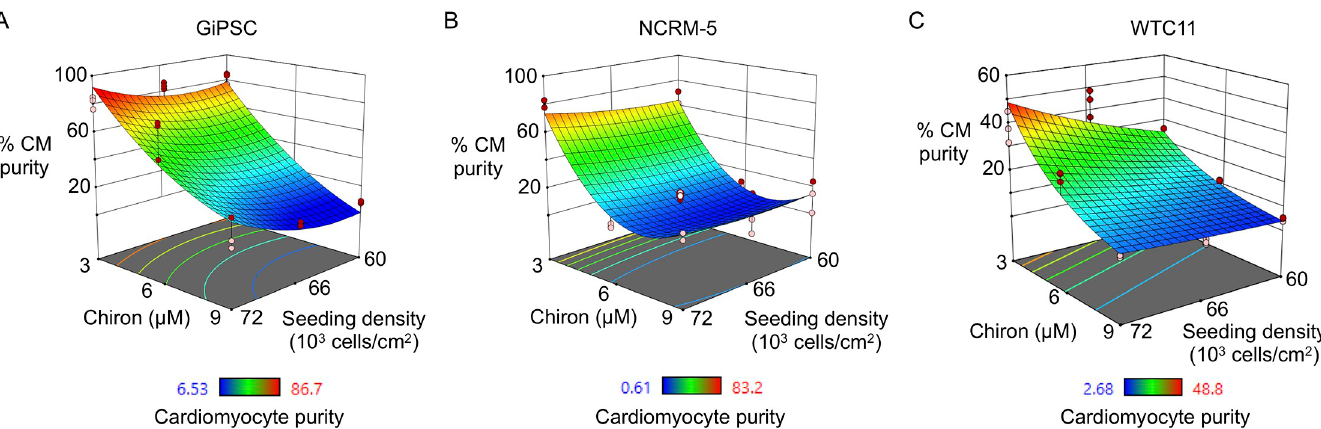
Fig 2. Chiron concentration and seeding density uniquely affect cardiac differentiation outcome. DOE (design of experiments) surface plots of directed differentiation outcomes in human induced pluripotent stem cell lines obtained from commercial (GiPSC; A), national bank (NCRM-5; B), and research institution (WTC11; C) sources. Red and pink circles indicate design points above and below predicted values, respectively. N = 9 per group per condition from 3 biological replicates (i.e., batches of hiPSC-cardiomyocytes).